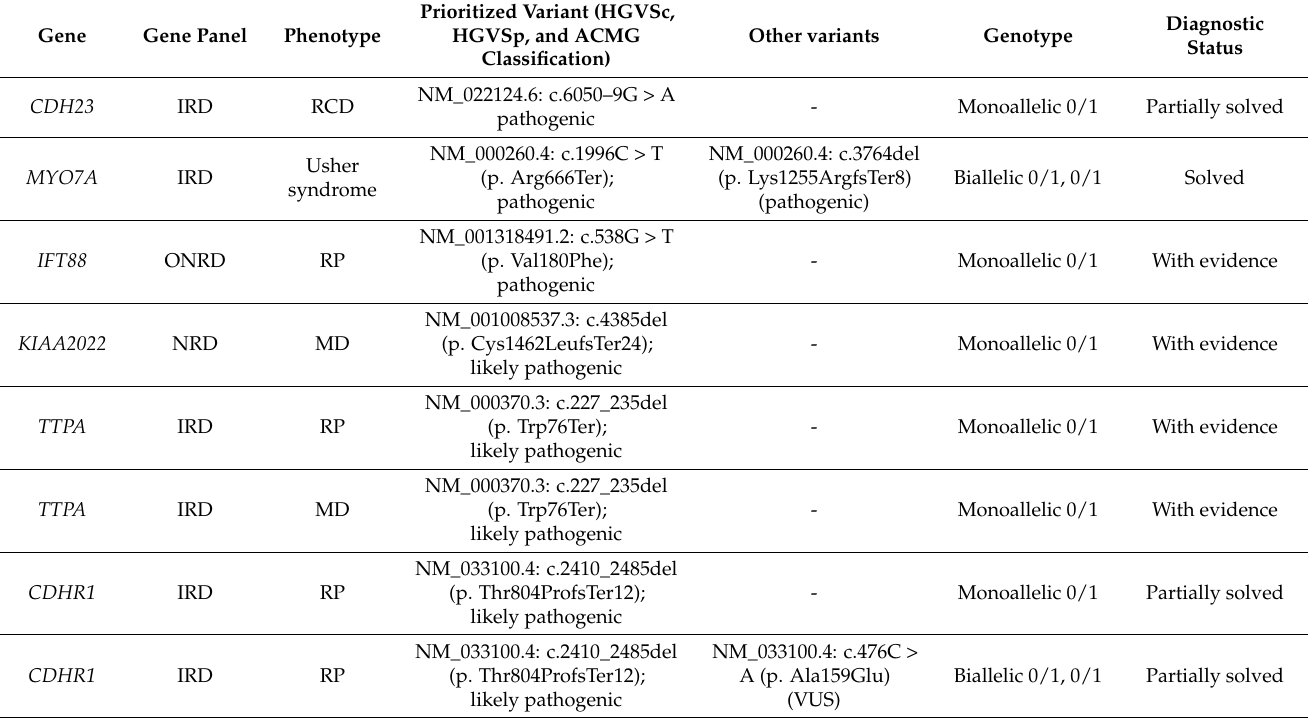
Table 1. Identification of most frequent variants in IRD (IRD-MFV) allowed for the reevaluation of non-solved IRD cases. A total of 8 cases (one per row) gained knowledge in their reassessment. The gene panel column refers to the type of diseases that the gene has been associated with, inherited retinal dystrophies (IRD), other eye-related diseases (OERD), and other non-eye-related diseases (NRD). In the phenotype, abbreviations are RCD: rod-cone dystrophy, RP: retinitis pigmentosa, and MD: macular dystrophy. In variant column: HGVSc, HGVSp, and ACMG classification are included. In “Other Variants”, for those biallelic cases, the second variant found after reviewing the case is included. Genotype column has information about the genotype of the variant(s) in the sample. Diagnostic status column has the new diagnostic status of the case after the reanalysis, as (1) “solved”, when the case has a conclusive diagnosis thanks to the variant(s) identified; or (2) “non-solved”, in any other case. Non-solved cases were annotated according to findings that may help in a future diagnosis as (2.1) “partially solved”, if a heterozygous pathogenic or likely pathogenic variant is found within a recessive gene that fits the observed phenotype; and (2.2) “with evidence”, when the variants identified in the analysis are: (2.2.1) pathogenic/likely pathogenic variants in genes not yet associated with the disease but with some evidence published in the literature or with overlapping phenotypes, or (2.2.2) VUS in a gene associated with the phenotype when one VUS in dominant or 1–2 VUS in recessive genes were